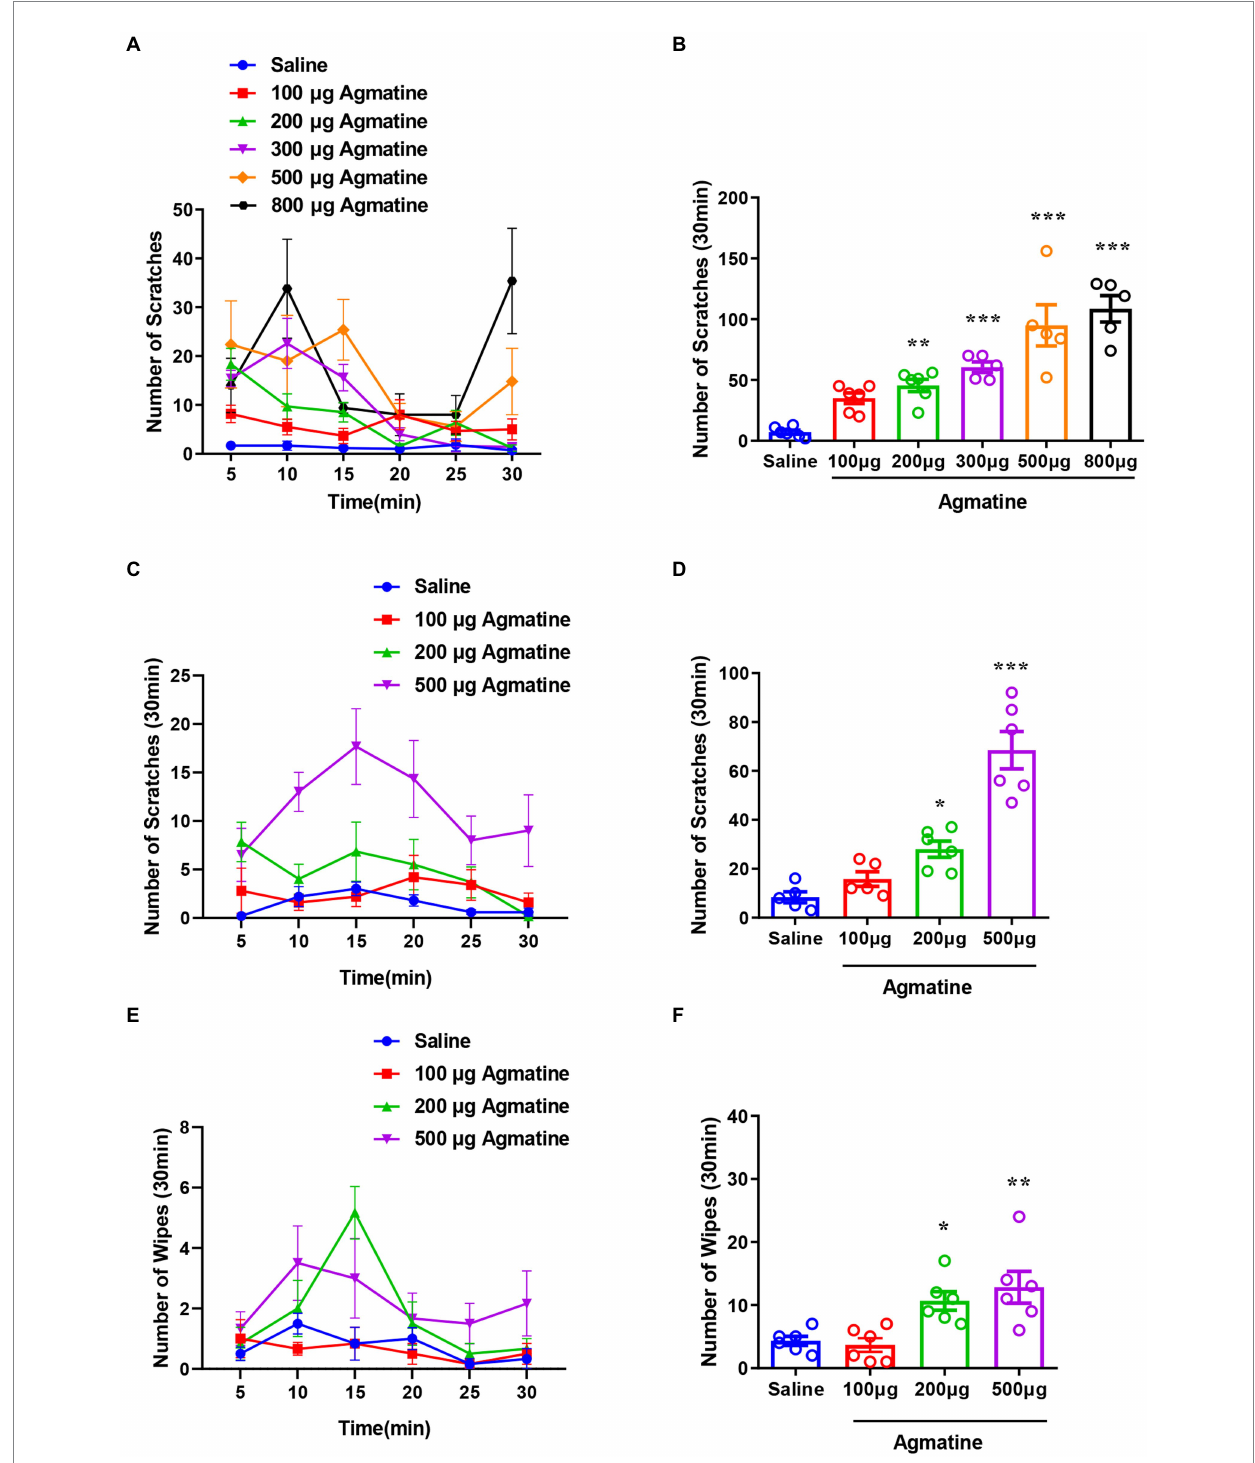
FIGURE 1 Agmatine evoked acute itch in mice. The time course (A) and the total number (B) of scratching behavior events within 30 min in response to an intradermal (i.d.) injection of agmatine (100–800 μ g) in the nape of the neck in mice. The time course (C) and the total number (D) of scratching behavior events within 30 min of an i.d. injection of agmatine (100–500 μ g) into the cheek of mice. The time course (E) and the total number (F) of wiping behavior events within 30 min of an i.d. injection of agmatine (100–500 μ g) into the cheek of mice (* p < 0.05, ** p < 0.01, *** p < 0.001 vs. Saline, one-way AVOVA following Bonferroni’s test; n = 5–6). All data are expressed by mean ±